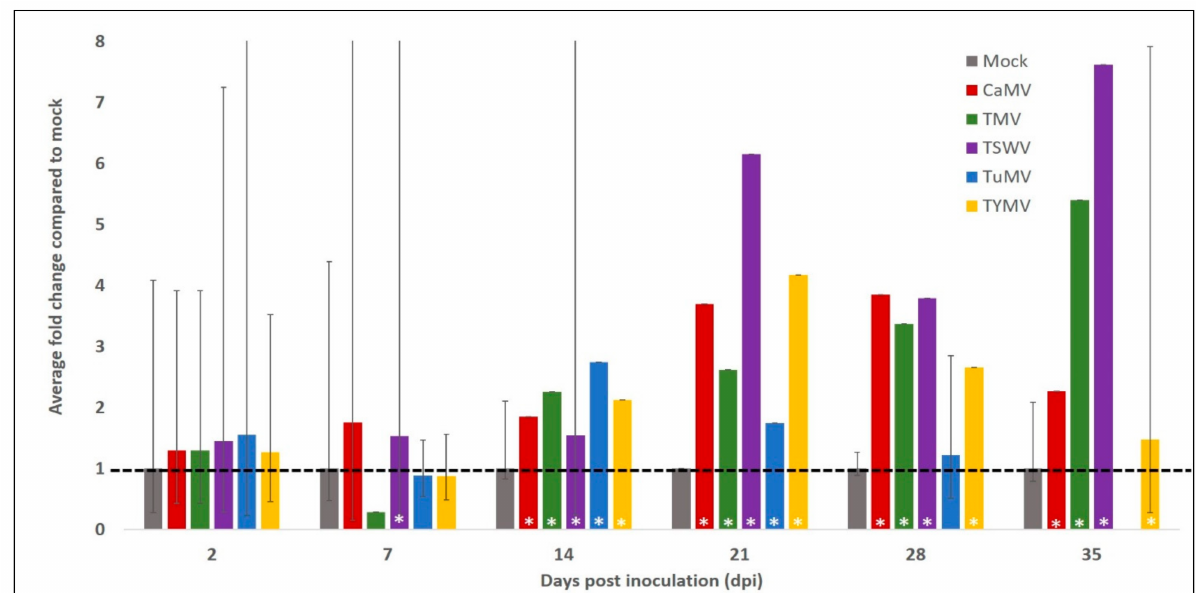
Figure 5. Average fold change of AtCPK3 transcript accumulation in virus infection. Log transformed, mean centred and auto-scaled AtCPK3 transcript accumulation of three biological replicates of mock-inoculated and virus-inoculated plants. Data normalised to the reference gene SAND . Virus- inoculated data were compared to mock-inoculated data of the same days post inoculation (dpi) (2, 7, 14, 21, 28, and 35). Error bars are upper 95% confidence level (+95% CI). Asterisk (*) indicate statistically significant difference to the mock in each time point. CaMV, cauliflower mosaic virus; TMV, tobacco mosaic virus; TSWV, tomato spotted wilt virus; TuMV, turnip mosaic virus; TYMV, turnip yellow mosaic